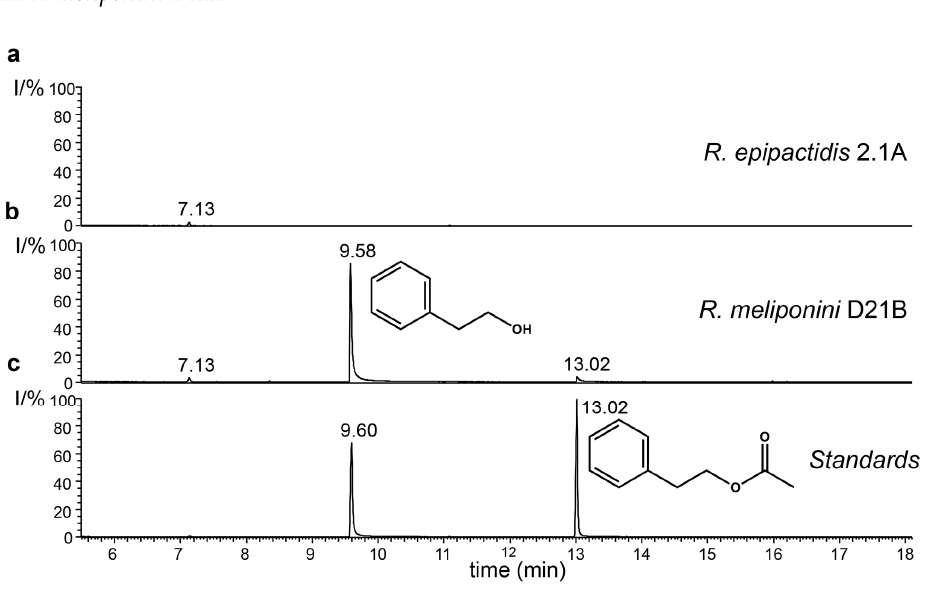
Figure 7. Comparison of 2-phenylethanol and 2-phenylethyl acetate production by R. meliponini D21B and R. epipactidis 2.1A. ( a ) Total ion current chromatogram of SPME collected volatiles from R. epipactidis 2.1A. ( b ) Total ion current chromatogram of SPME collected volatiles from R. meliponini D21B. ( c ) Total ion current chromatogram (TIC) of SPME collected 2-phenylethanol and 2-phenylethyl acetate standards.